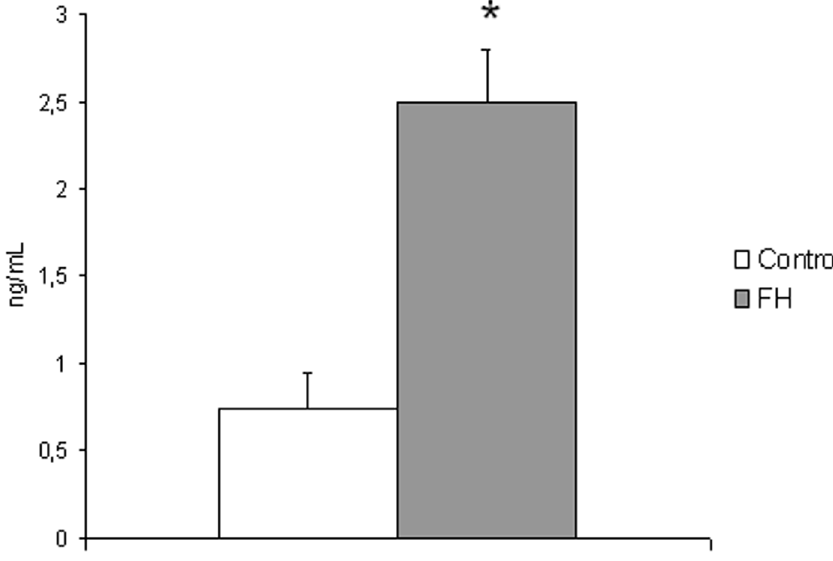
Figure 1. Plasma levels of PTX3 in control (n=20) and FH patients (n=19). P=0.0002.